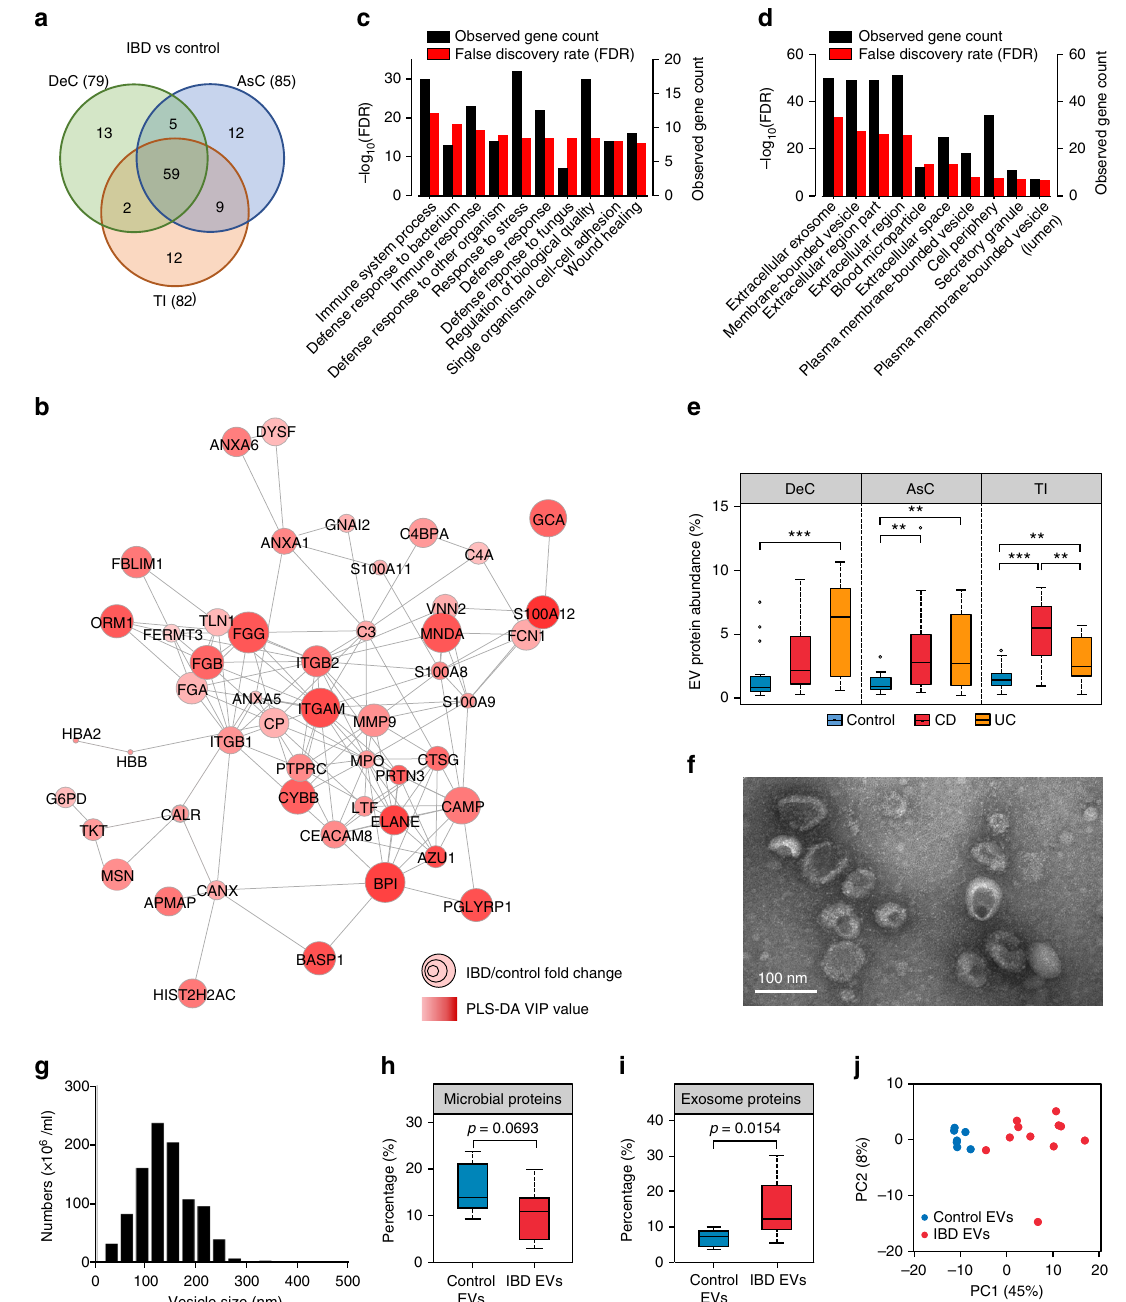
Fig. 6 Alteration of MLI human proteins in pediatric IBD patients. a Numbers of differentially abundant proteins identi fi ed by PLS-DA with a threshold of VIP ≥ 2. The numbers in brackets indicate the total number of proteins identi fi ed for each intestinal region. b Protein – protein interaction network of the 59 differentially abundant MLI human proteins at all three intestinal regions in IBD. c Top biological processes and d top cellular components enriched by the differentially abundant MLI human proteins in IBD. e Percentage of EV related proteins in the MLI human proteomes. For the box plot, the bottom and top of the box are the fi rst and third quartiles, respectively. The middle line represents the sample median. Whiskers are drawn from the ends of the IQR to the furthest observations within the 1.5 times the IQR range. Outliers > 1.5 times the IQR are indicated with circle. * p < 0.05, ** p < 0.01, ** p < 0.001. f Electron microscopy of isolated vesicles. g Nanoparticle tracking analysis of the isolated vesicle size distribution from DeC aspirates of patient HM537. h Percentage of microbial proteins in the isolated EV proteomes. i Percentage of exosome proteins matching to the top 100 proteins in ExoCarta database. j PCA score plot of the free EV human proteomes from patients with or without